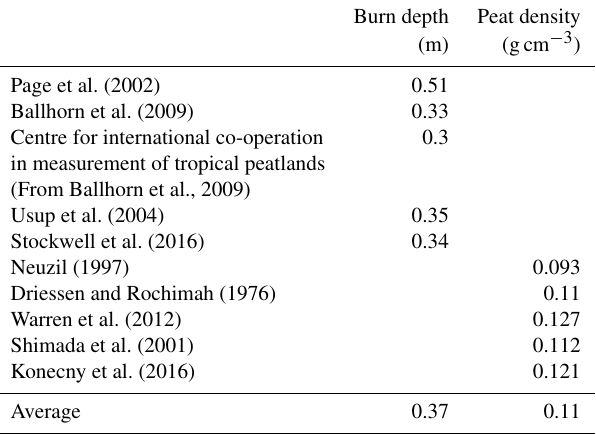
Table 1. Values for peat burn depth and peat density found in pre- vious studies and the average value across studies. All studies were based in Kalimantan,